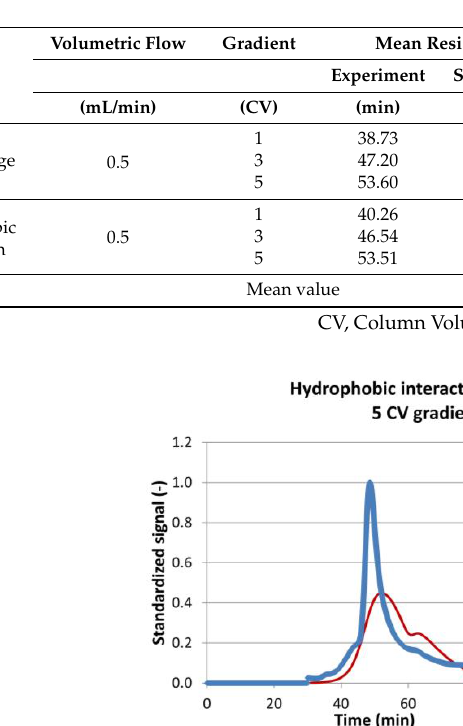
Table 1. Overview of the simulation results for IgG on ion-exchange and hydrophobic interaction membranes.